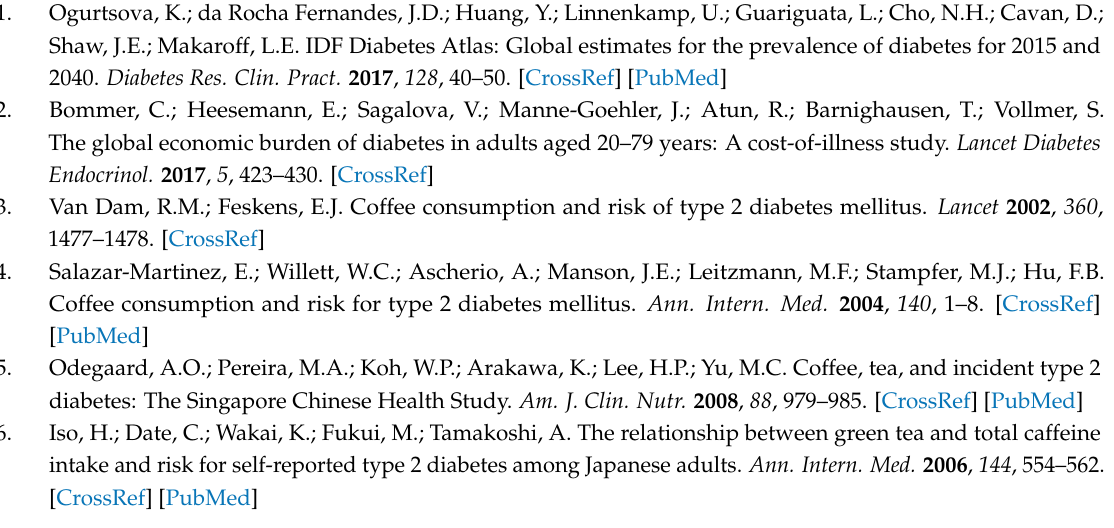
Search strategy, supplemental Figure S1a: Meta-regression graph between effects of green tea on fasting blood glucose and study mean age; Figure S1b: Meta-regression graph between effects of green tea on fasting blood glucose and intervention duration (weeks); Figure S1c: Direct pairwise meta-analysis, effects of green tea on fasting blood glucose levels, stratified by non-diabetic, prediabetic, and diabetic subjects; Figure S2: Comparison-adjusted funnel plot of effects on fasting blood glucose level; Figure S3: Direct pairwise meta-analysis forest plot of effects on 2-h oral glucose tolerance test results for blood glucose vs. placebo/water; Figure S4: Comparison-Adjusted Funnel Plot of effects on 2-h oral glucose tolerance test results for blood glucose vs. placebo/water; Figure S5: Direct pairwise meta-analysis forest plot of effects on HbA1c vs. placebo/water; Figure S6: Comparison-Adjusted Funnel Plot of effects on HbA1c vs. placebo/water; Figure S7: Direct pairwise meta-analysis forest plot of effects on fasting blood insulin vs. placebo/water; Figure S8: Comparison-Adjusted Funnel Plot of effects on fasting blood insulin vs. placebo/water; Figure S9: Direct pairwise meta-analysis forest plot of effects on HOMA-IR vs. placebo/water; Figure S10: Comparison-Adjusted Funnel Plot of effects on HOMA-IR vs. placebo/water; Figure Table S1 Search strategy, Table S2 Effects on fasting blood glucose vs. placebo/water, analyzed without oolong